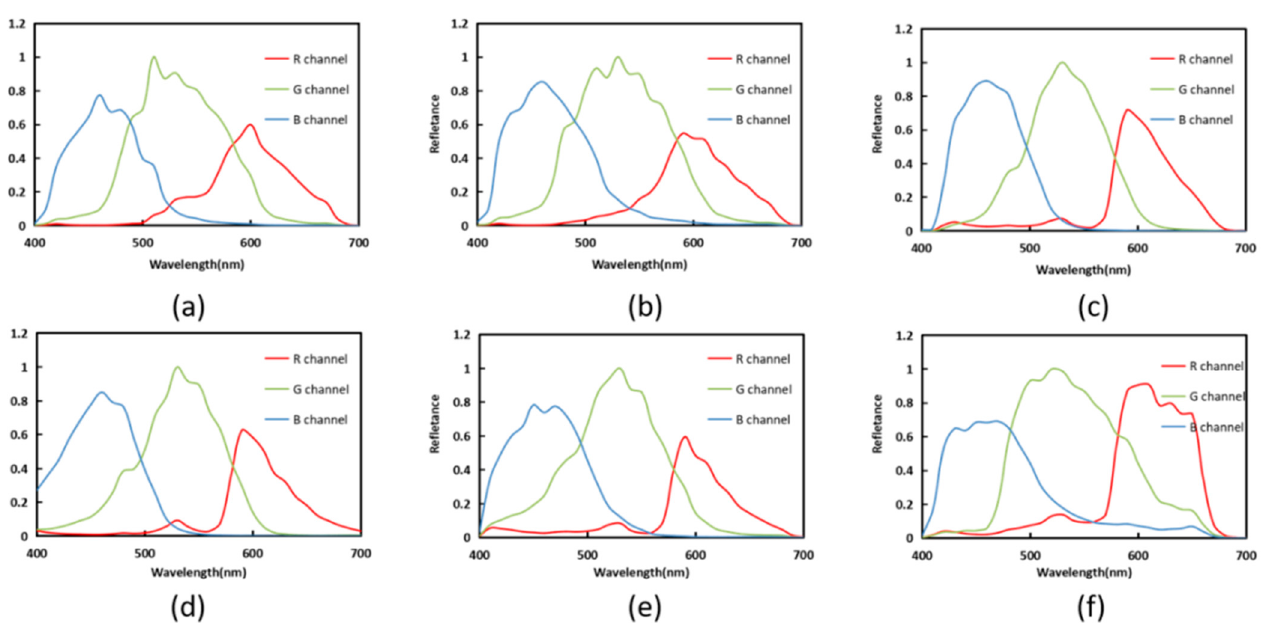
Table 7. Results of recovery spectral reflectance for different illuminants using different spectral recovery methods and Canon5D Mark II spectral sensitivity function.